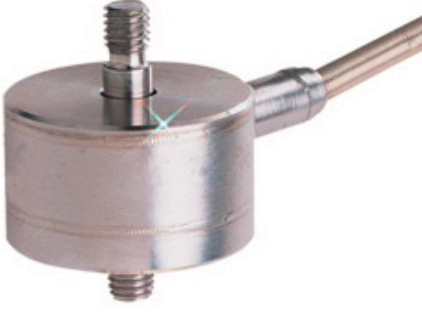
Figure 26. Omega engineering, LCMFD-20N load